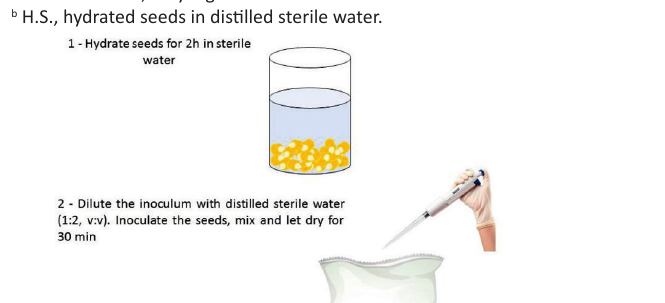
a Classification based in three biological replicates, each with three technical replicates, as follows: very low recovery: zero or close to zero CFU per 100µL of recovery sample; low recovery: up to 200 CFU per 100µL of recovery sample; medium recovery: between 200 and 500 CFU per 100 לL of recovery sample; high recovery: between 500 and 700 CFU per 100µL of recovery sample; very high: >700 CFU per 100µL of recovery sample; corresponding to very low recovery: zero or close to zero CFU seed -1 ;